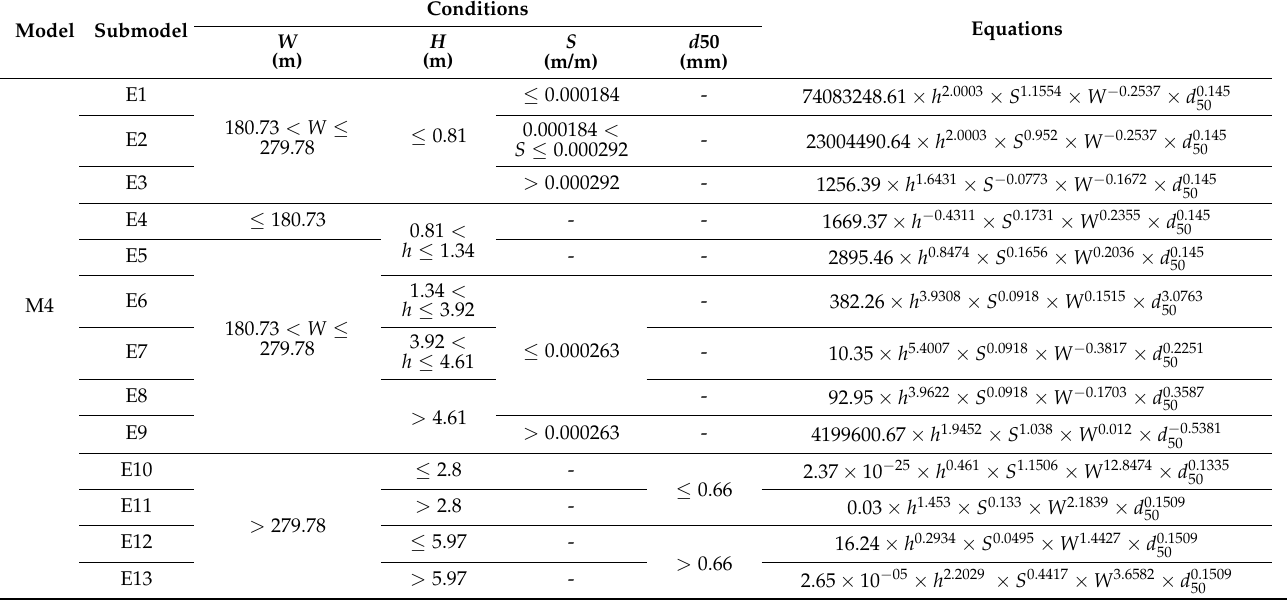
Table 4. Application conditions and determination coefficients of Model 4